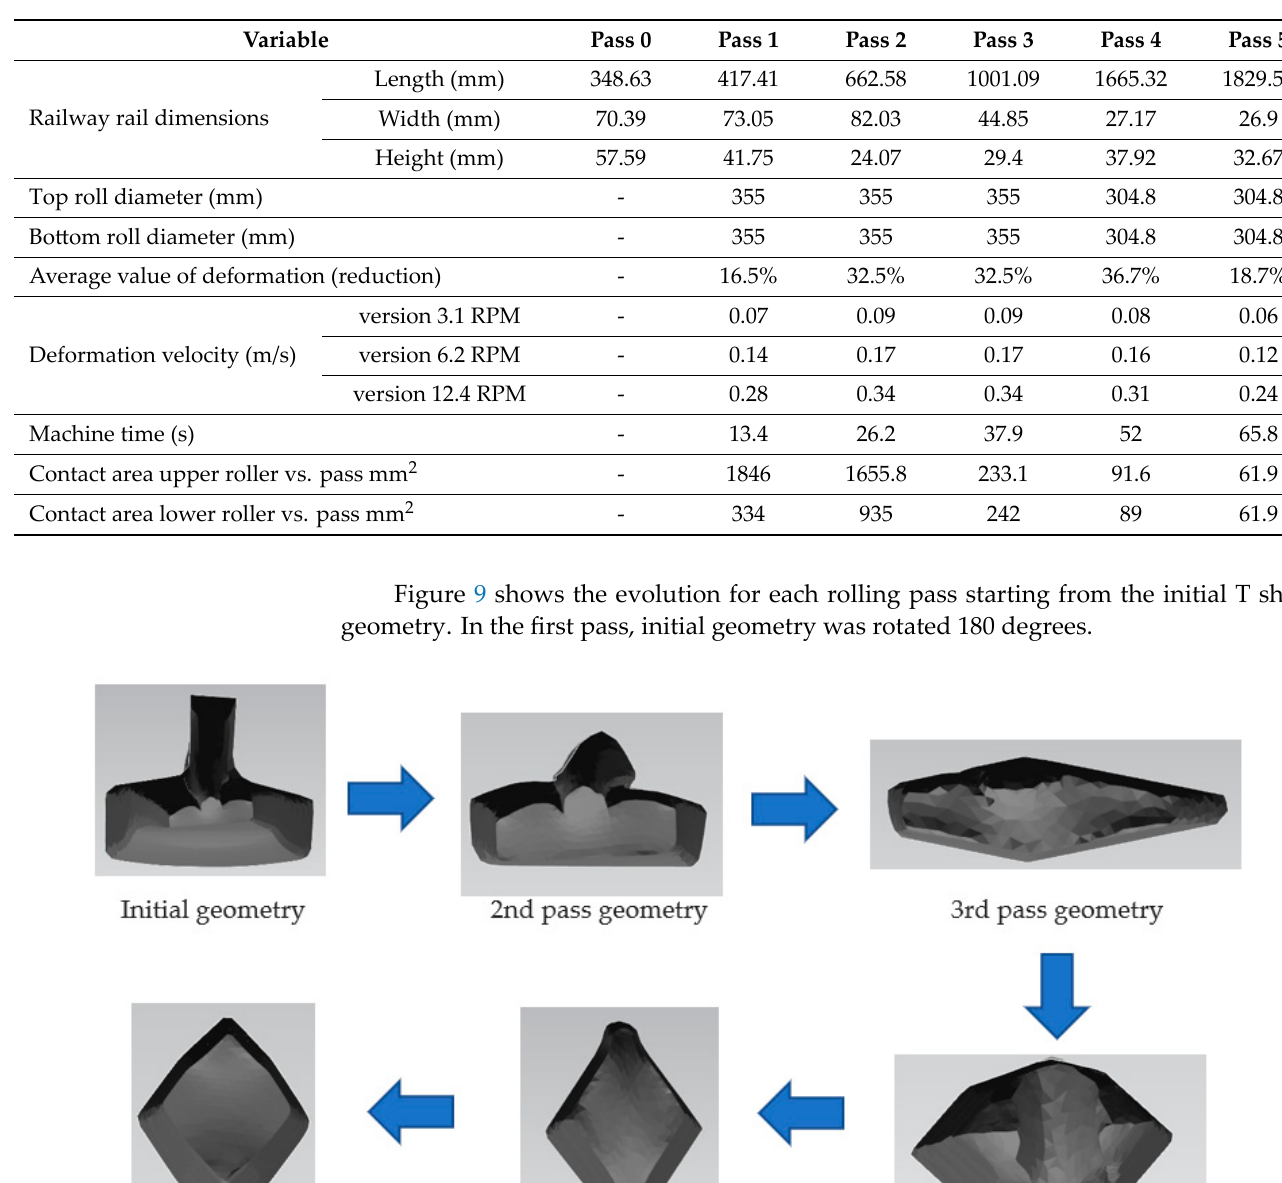
Table 3. Basic information about DEFORM simulations for each pass.